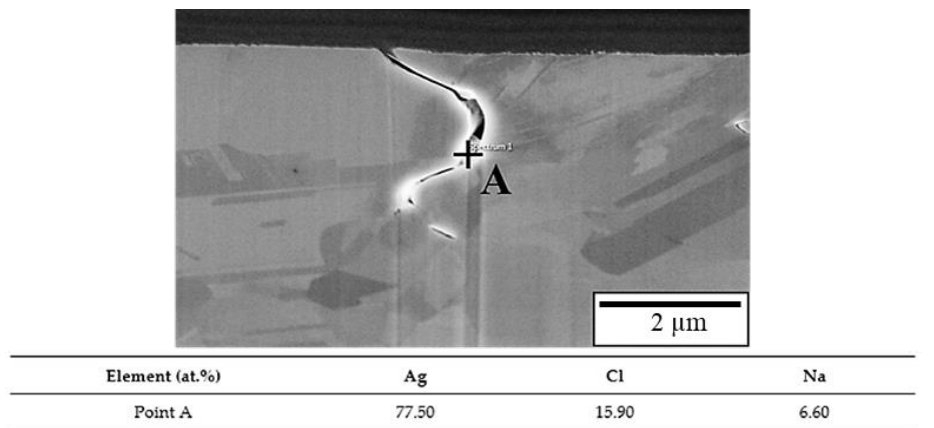
Figure 4. Tensile fracture cross-section of the APAP wire after 4 h of chlorination: ( a ) focus ion beam (FIB) surface scanning, and ( b ) cross-section image.